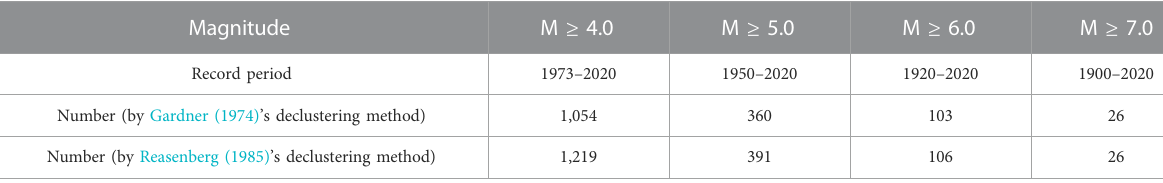
TABLE 2 Interval of recurrence models. Model name Probability density function and cumulative distribution function of statistical models and their Exponential